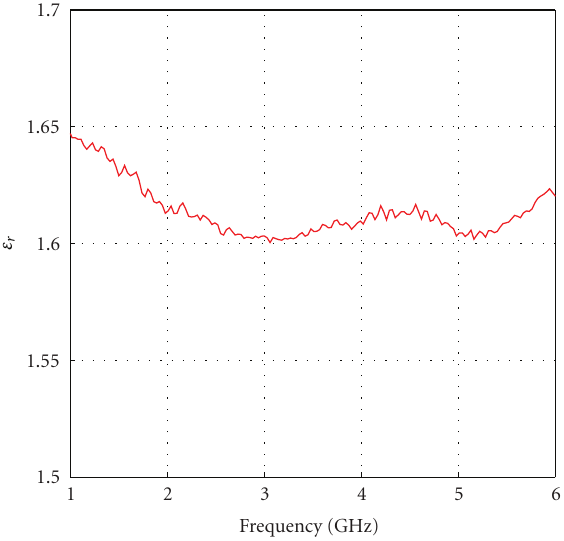
Figure 5: Measured permittivity versus frequency for denim.